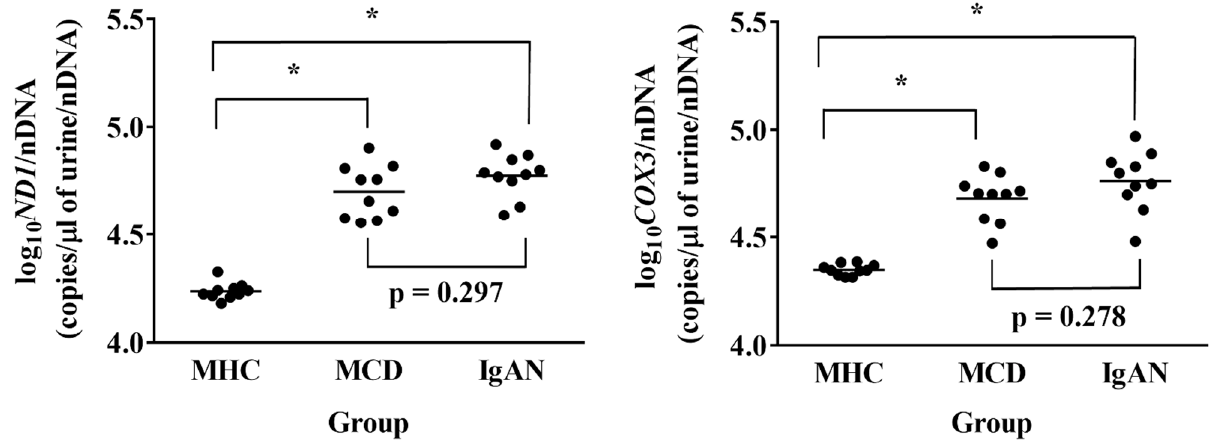
Figure 2. Urinary mitochondrial DNA copy numbers in the matched healthy control (MHC), minimal change disease (MCD), and immunoglobulin A nephropathy (IgAN) groups in the prospective study. Data were analyzed by via one-way ANOVA with Bonferroni correction. * p < 0.001. ND1, mitochondrially encoded NADH dehydrogenase 1; COX3, cytochrome-c oxidase-3.